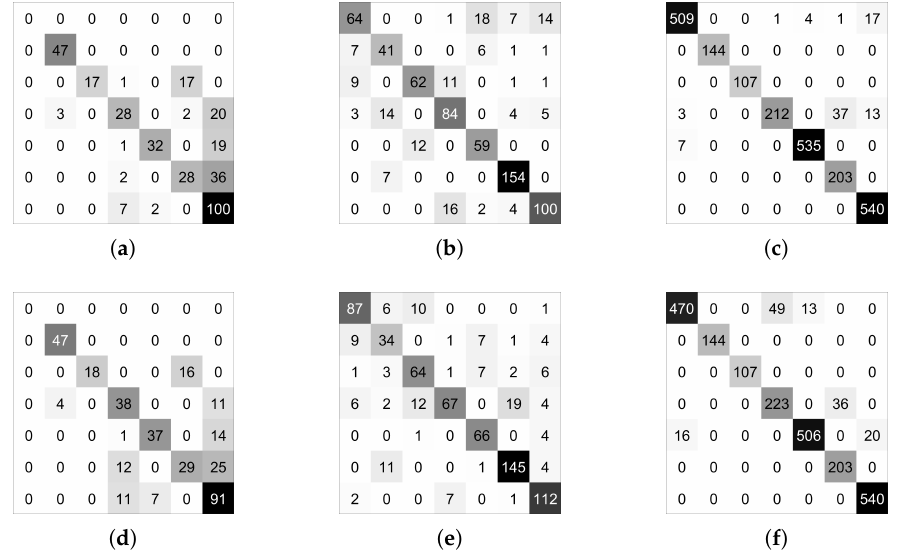
Figure 17. Different confusion matrix results in ( a ) student KITTI-ROAD, ( b ) student KITTI-360, ( c ) student Alcalá, ( d ) metric KITTI-ROAD, ( e ) metric KITTI-360, and ( f ) metric Alcalá. Please notice that in panels (a,d) we did not introduce straight roads (type-zero